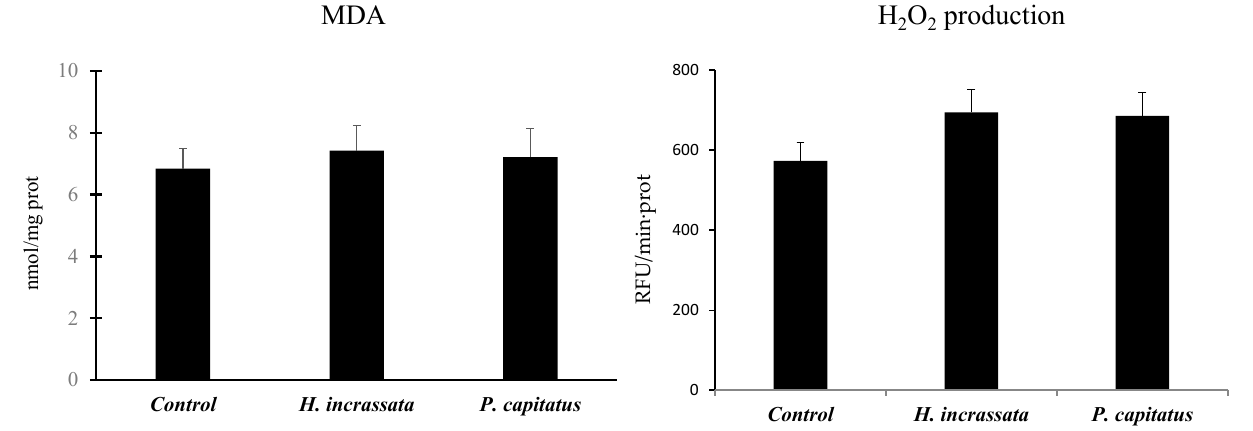
Figure 4. Levels of malondialdehyde (MDA) and production of H 2 O 2 in samples of P. pavonica (control) alone or coexisting with the invasive H. incrassata or P. capitatus . No significant differences were found between groups (one-way ANOVA). Values are expressed as mean ± S.E.M.